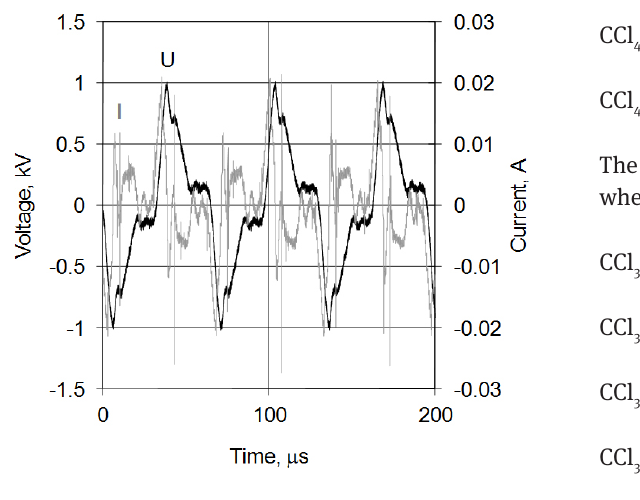
Figure 5 : The dependence between the CCl energy for the spark